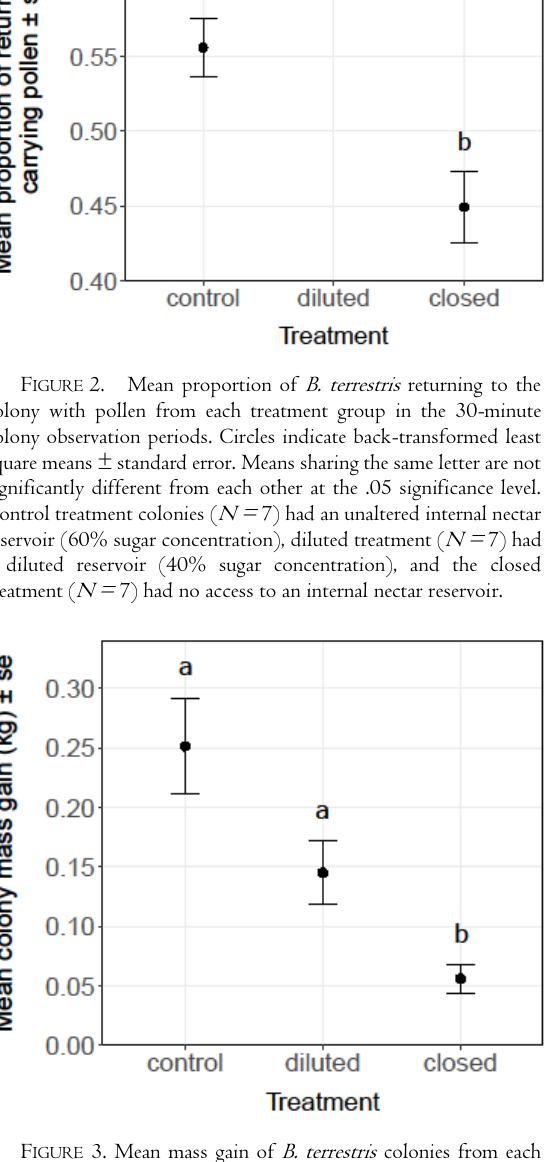
F IGURE 3. Mean mass gain of B. terrestris colonies from each treatment group. Circles indicate back-transformed least square means ± standard error. Means sharing the same letter are not significantly different from each other at the .05 significance level. Control treatment colonies (N = 7) had an unaltered internal nectar reservoir (60% sugar concentration), diluted treatment (N = 7) had a diluted reservoir (40% sugar concentration), and the closed treatment (N = 7) had no access to an internal nectar